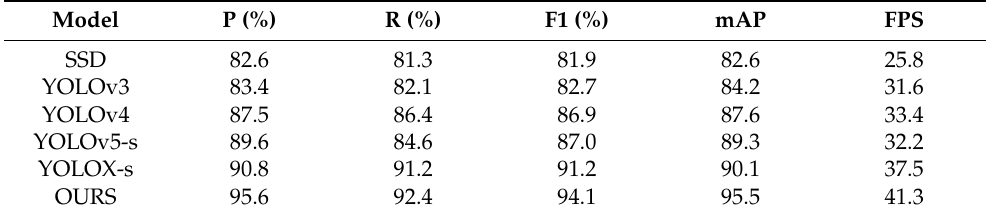
Table 3. Performance comparison under different